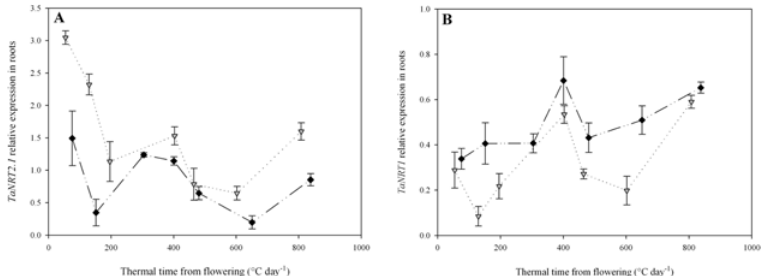
Fig 4. Relative expression patterns of TaNRT2 . 1 (A) and TaNRT1 (B) genes in roots from flowering (GS65) to GS65+800DD for two contrasting NO 3- treatments (N4 and N10). Values are the means of three biological repetitions ± 1 standard error for N4 (grey triangles) and N10 (black diamonds). Quantification was performed by qRT-PCR. Relative expression values were calculated using the Δ CT method corrected for primer efficiency, using Ta54280 and Ta54948 as internal